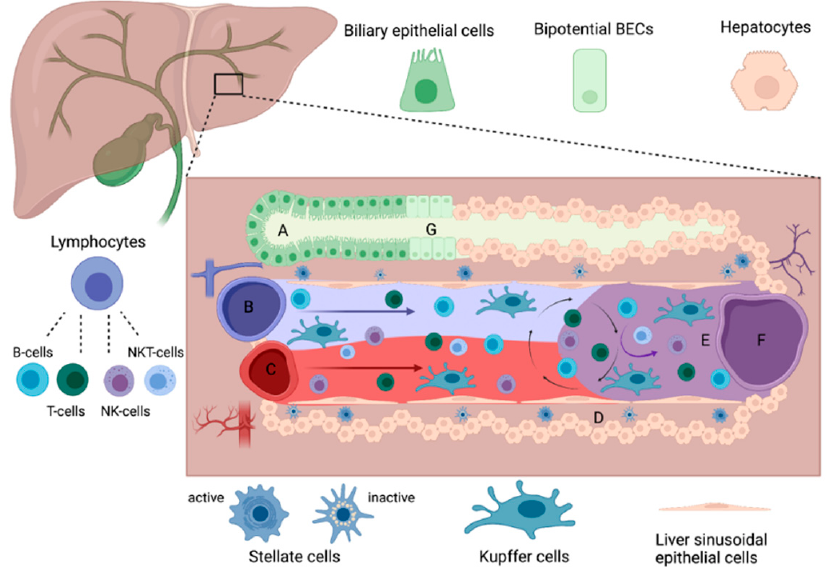
Figure 1. Histoarchitecture of the liver. The portal triad is composed of the bile duct ( A ), the portal vein ( B ), and the hepatic artery ( C ) [8]. The blood flows from the portal vein and hepatic artery through the sinusoids ( E ) towards the central vein ( F ), surrounded by fenestrated LSECs. Lymphocytes and KCs reside intravascular, whereas SCs are found in the space of Disse ( D ) [1]. BECs line the bile duct, where they modify the bile produced by hepatocytes. The junctional region between the bile duct and hepatocytes, known as the canal of Hering ( G ), harbors bipotential BECs